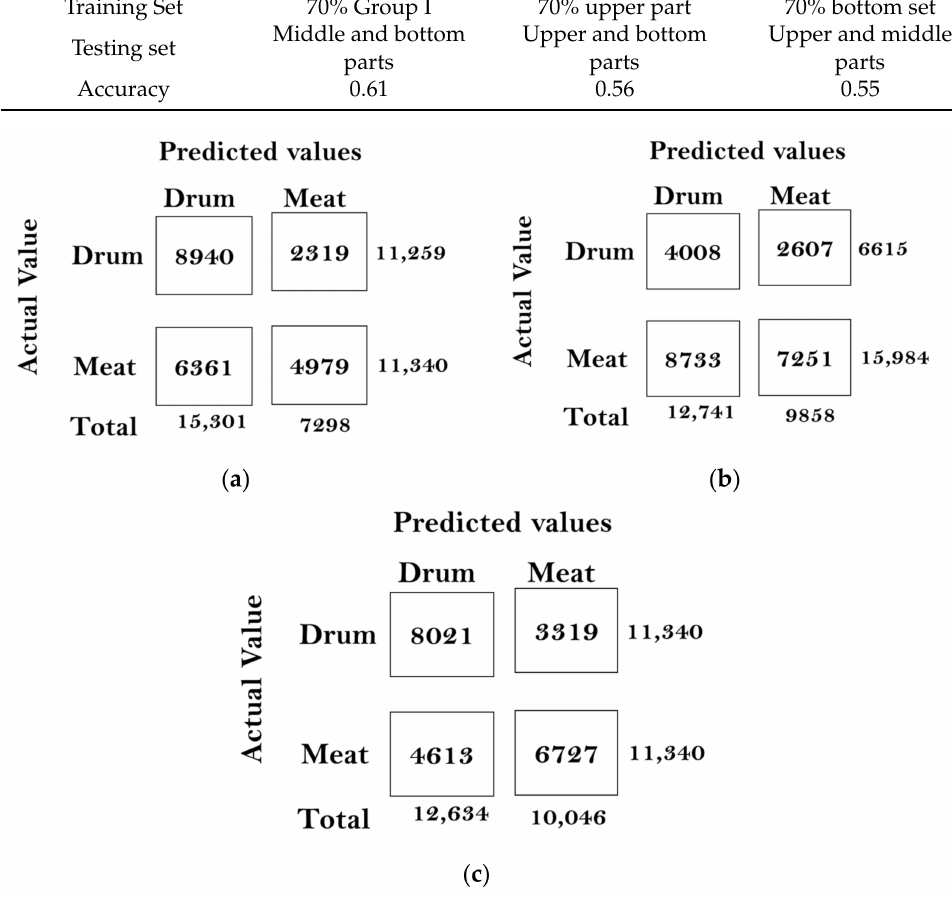
Figure 15. The confusion matrices ( a ) training on upper and testing on the middle and bottom parts; ( b ) training on the middle and testing on the upper and bottom parts; and ( c ) training on the bottom and testing on the upper and middle parts.